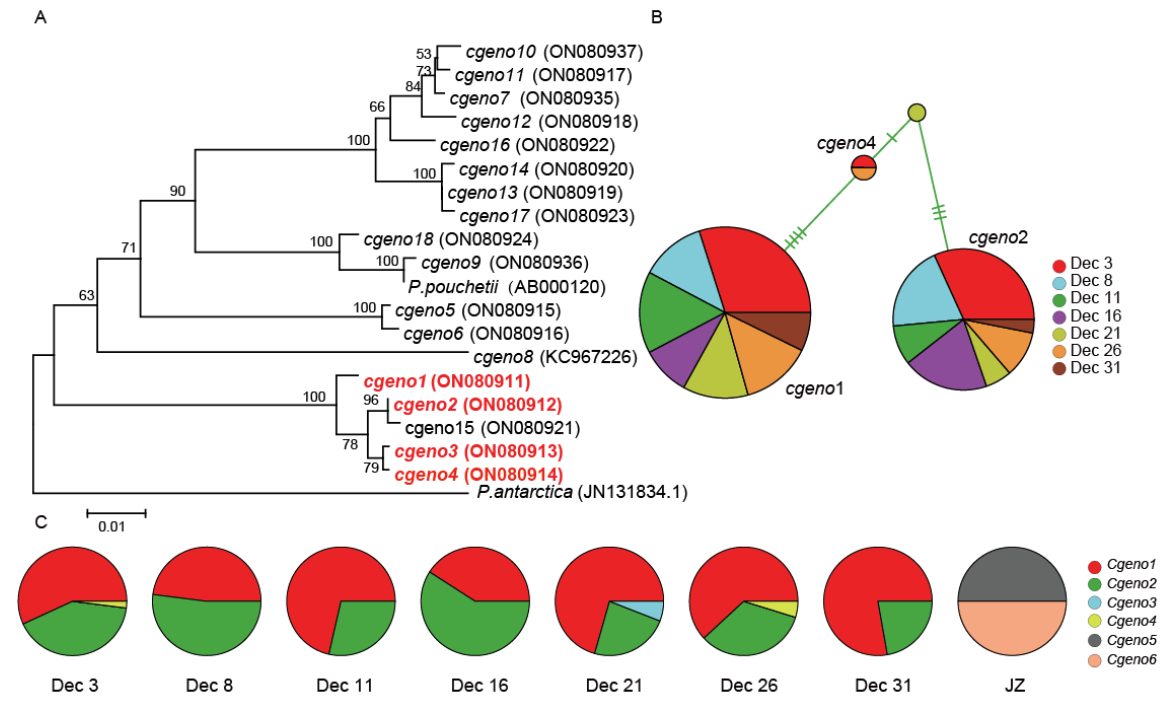
Figure 3. The phylogenetic analysis of P. globosa , genetic diversity and temporal dynamics of the P. globosa bloom using molecular marker cox1 . ( A ) The phylogenetic analysis based on cox1 non-redundant sequences, and the genotypes found in this bloom are in red. ( B ) A TCS network of the cox1 sequences of P. globosa that were obtained from 7 field samples. Each circle represents a different haplotype. The size of each circle is proportional to the number of sequences for each haplotype. Each line connecting two haplotypes indicates nucleotide change regardless of the length, and one bar on the lines represents one base difference. ( C ) Genotype composition at different sampling times. JZ: sample collected outsite of the Jiaozhou Bay in January 2019.